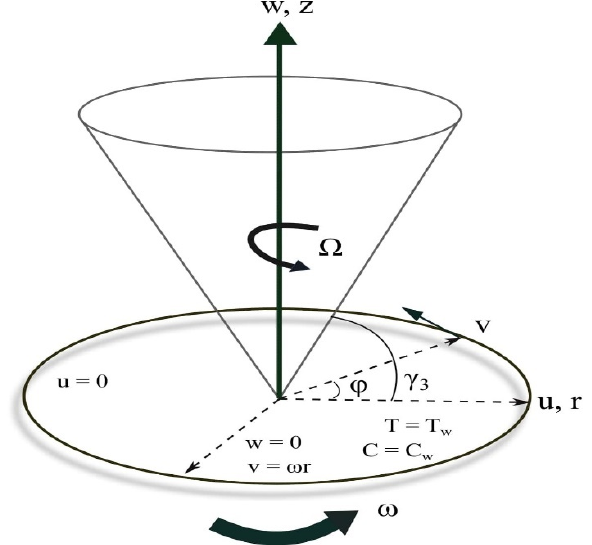
Figure 1. Geometry of the conical gap flow between a cone and disc. The diagram of the flow of fluid is depicted for the case of a rotating cone and disc with the velocity components ( u , v , w ) along the ( r , ϕ , z ) direction.